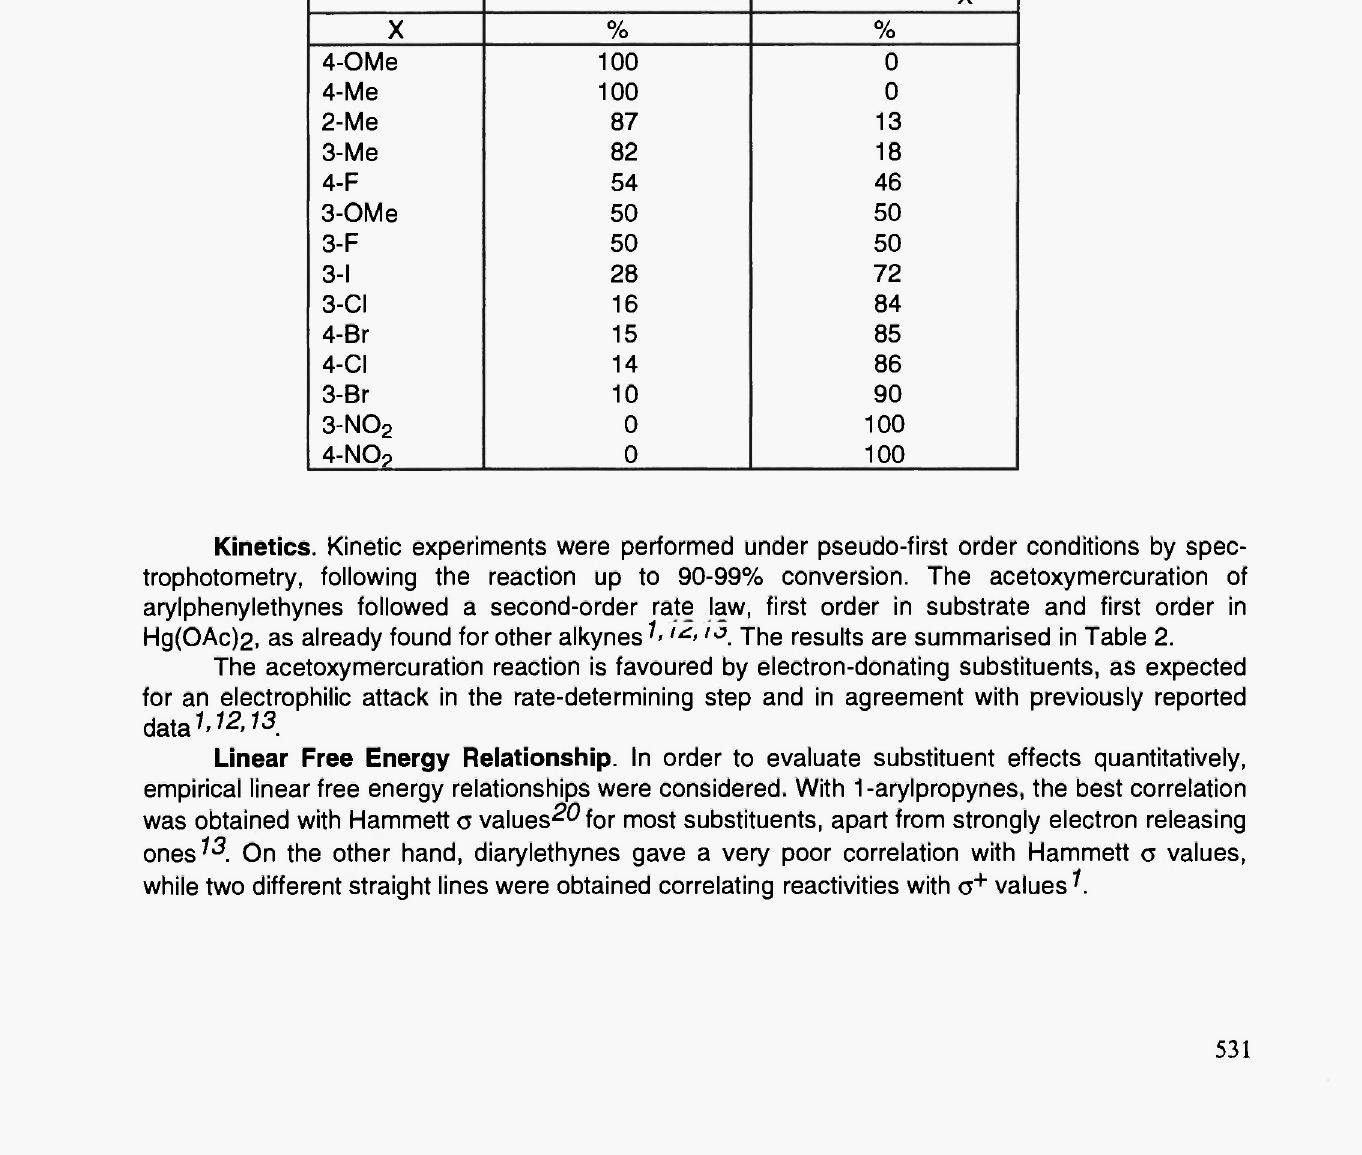
OAc HgOAc AcOHg \ =\ AcO / =\ vA Οχ X %